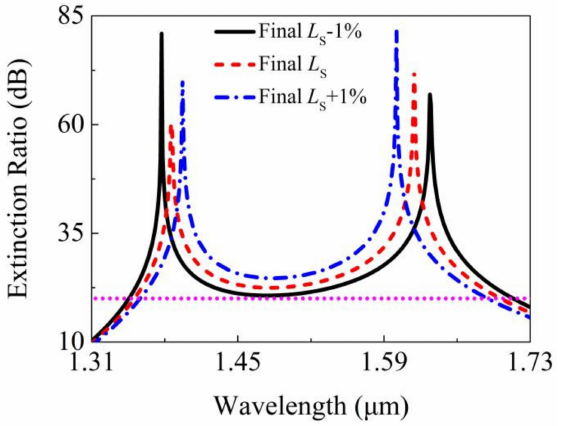
Figure 15. The relationship of the ER in the core A of the proposed LC-DC-PCF with wavelengths when the final L S changes ±